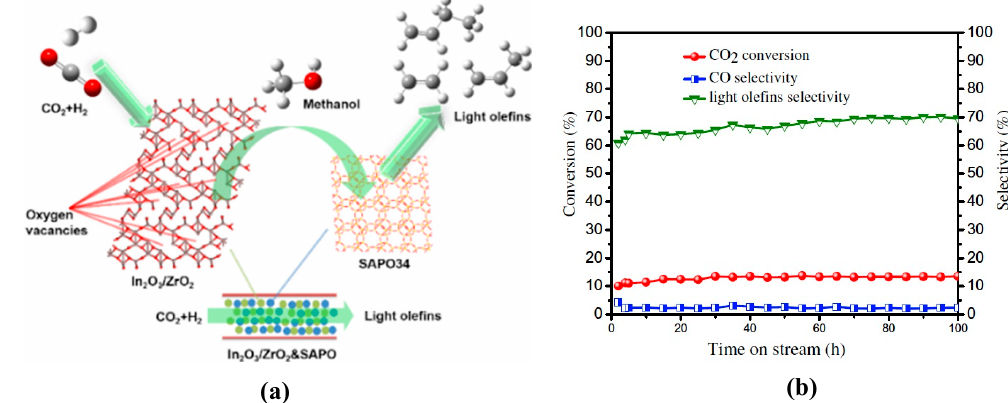
Figure 16. ( a ) Illustrated reaction mechanism over the bifunctional composite catalyst In 2 O 3 -ZrO 2 /SAPO-34, and ( b ) the stability of the In 2 O 3 -ZrO 2 /SAPO-34 composite catalyst for CO 2 hydrogenation to light olefins (testing conditions: P = 2.0 MPa, T = 573 K, GHSV = 2160 cm 3 h − 1 g cat − 1 ). Adapted with permission from ref. [44]. Copyright 2019 Elsevier.